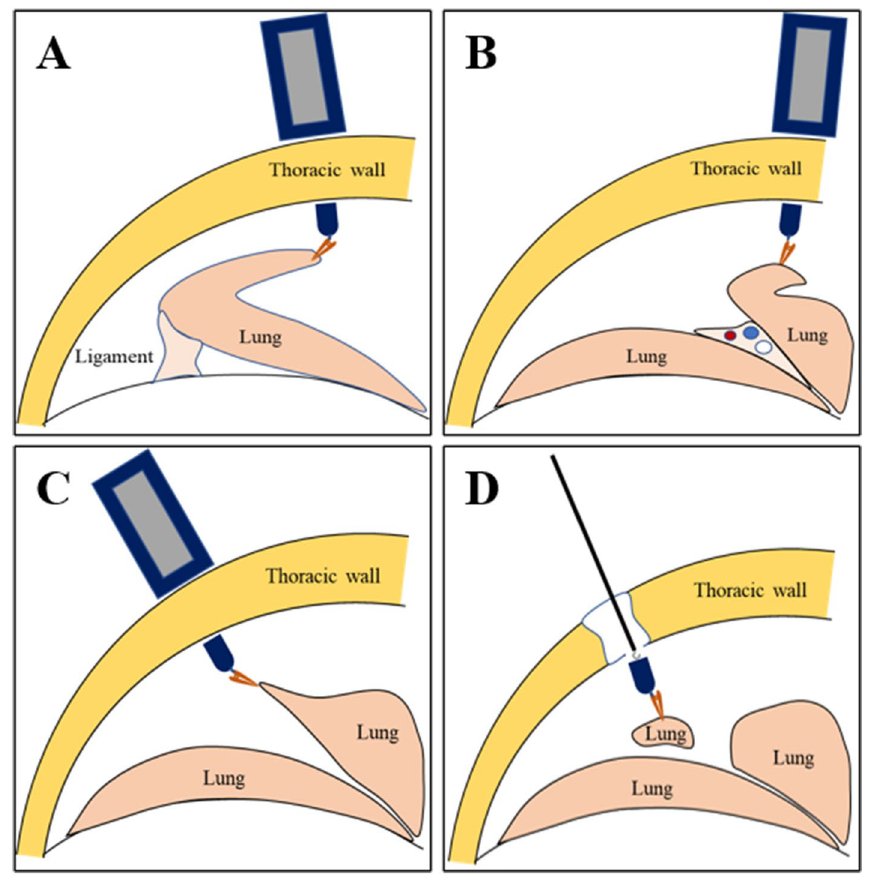
Figure 3. Schematic illustration of the use of a magnetic anchoring device in assisting thoracoscopic surgery. ( A ) Assist in exposing the hilum and separating the associated blood vessels. ( B ) Assist in the separation of ligaments. ( C ) Assist in the resection of lung tissue. ( D ) Take out the internal grasping forceps and lung tissue through the endoscopic